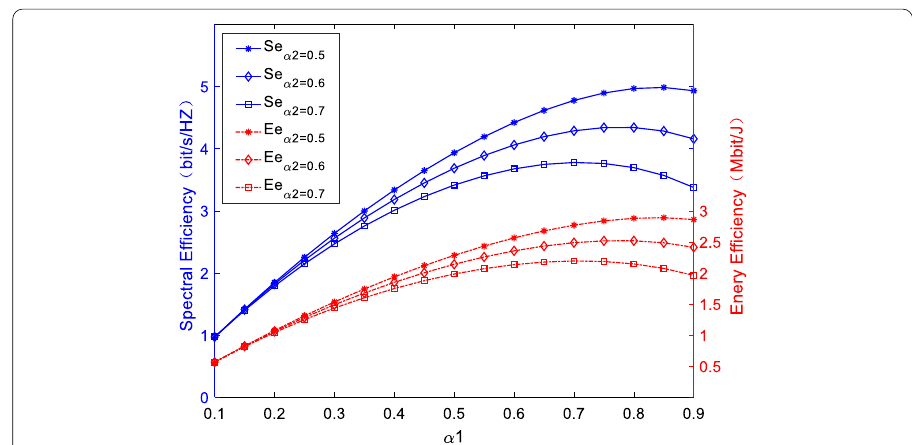
Fig. 5 Spectral efficiency and energy efficiency varying with α 1 in case of α 2 = 0.5,0.6,0.7